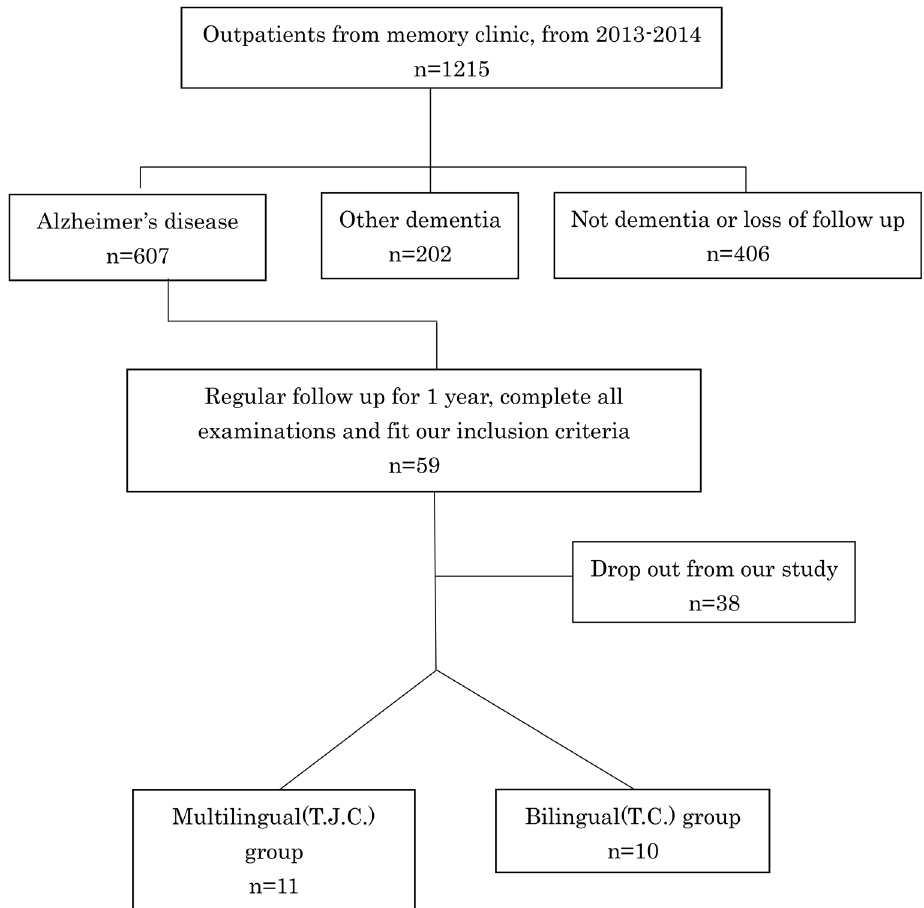
Fig 1. Flow chart of the subjects ’ selection from the memory clinic. From 2013 – 2014, 59 dementia patients from the memory clinic that met our inclusion criteria were selected. Ultimately, 21 patients agreed to participate in our